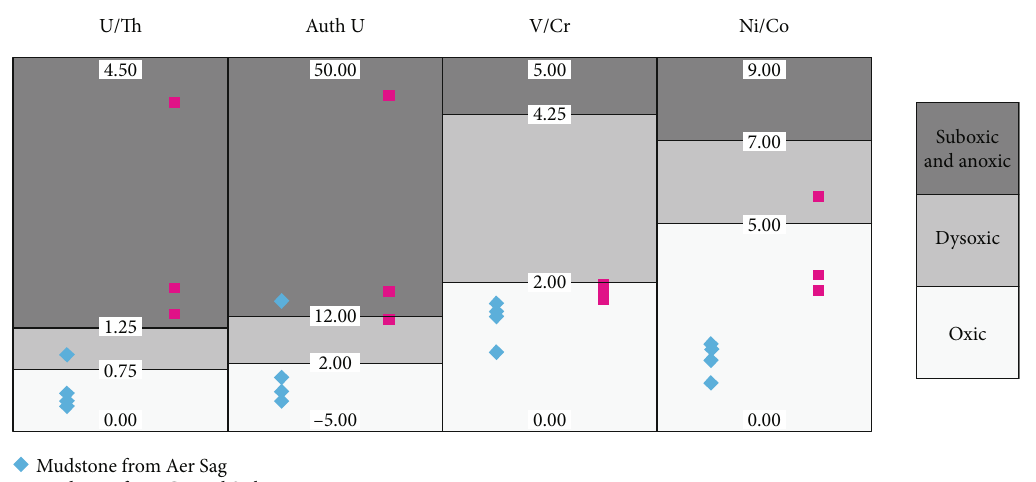
Figure 9: The identi fi cation of depositional environment of mudstones using trace element parameters (criteria of redox environments from